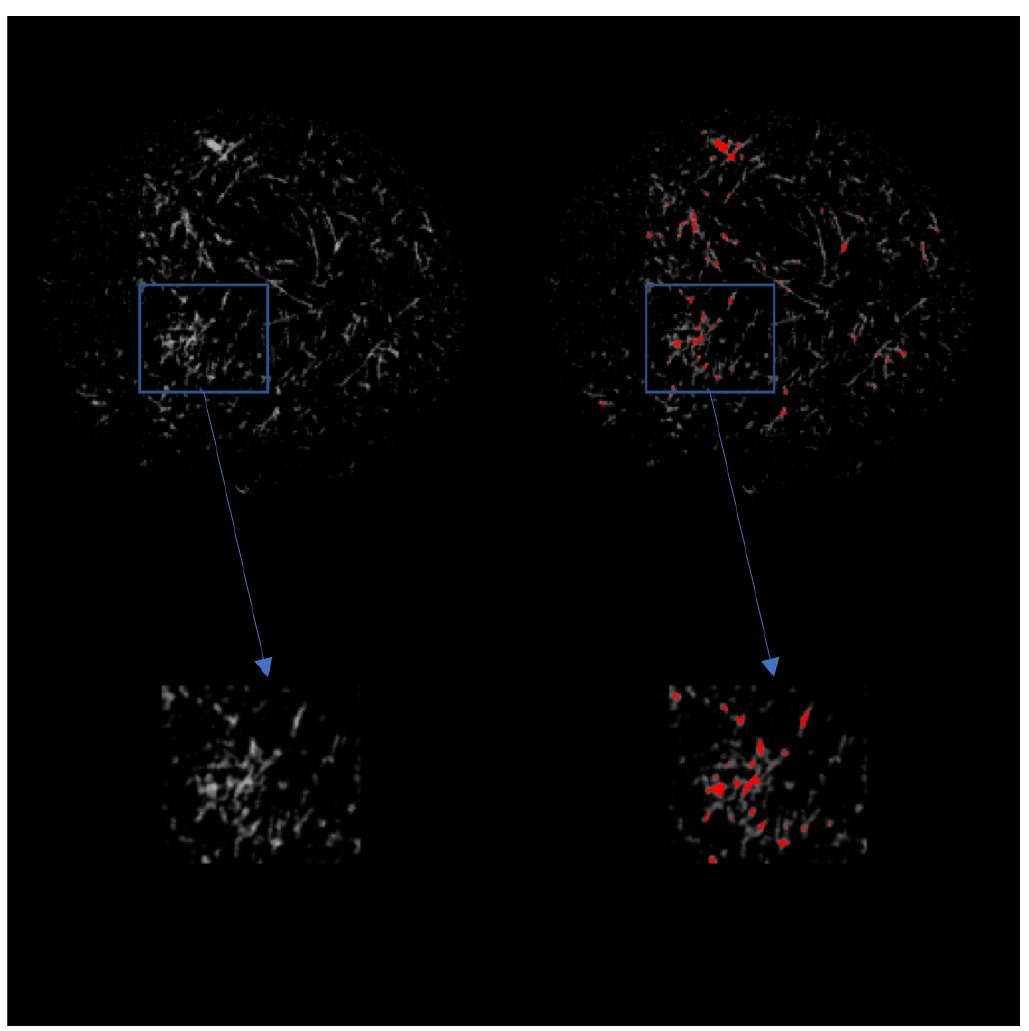
Figure 4. (Left) 2D grayscale view of the scaffold after µ CT imaging. The top row is a view of the entire scaffold, while the bottom row is a magnified view of the indicated area of interest. (Right) 2D view of the scaffold after µ CT imaging with ECM indicated in